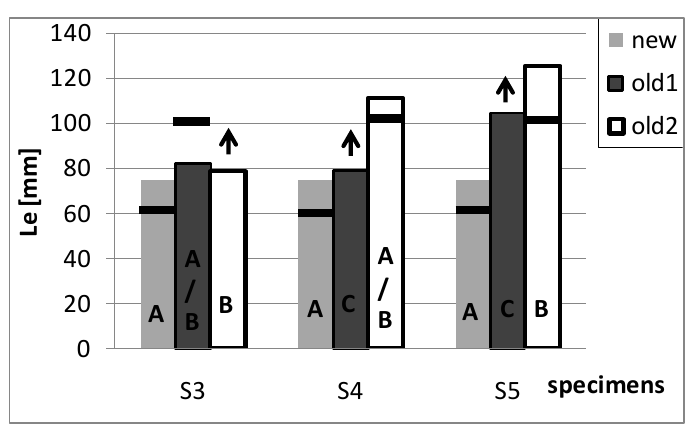
Figure 11. Optimal bond